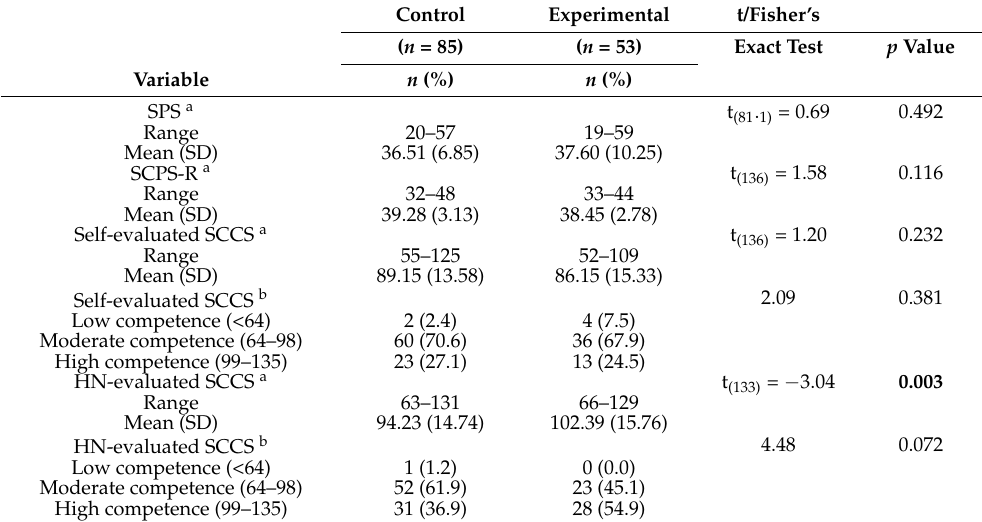
Table 4. Homogeneity test of outcomes at baseline ( n =